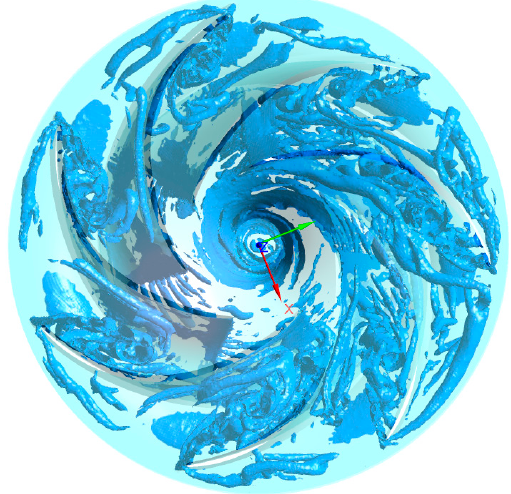
Figure 6. Vortex structures at 50%Pn (10% characteristic scale).